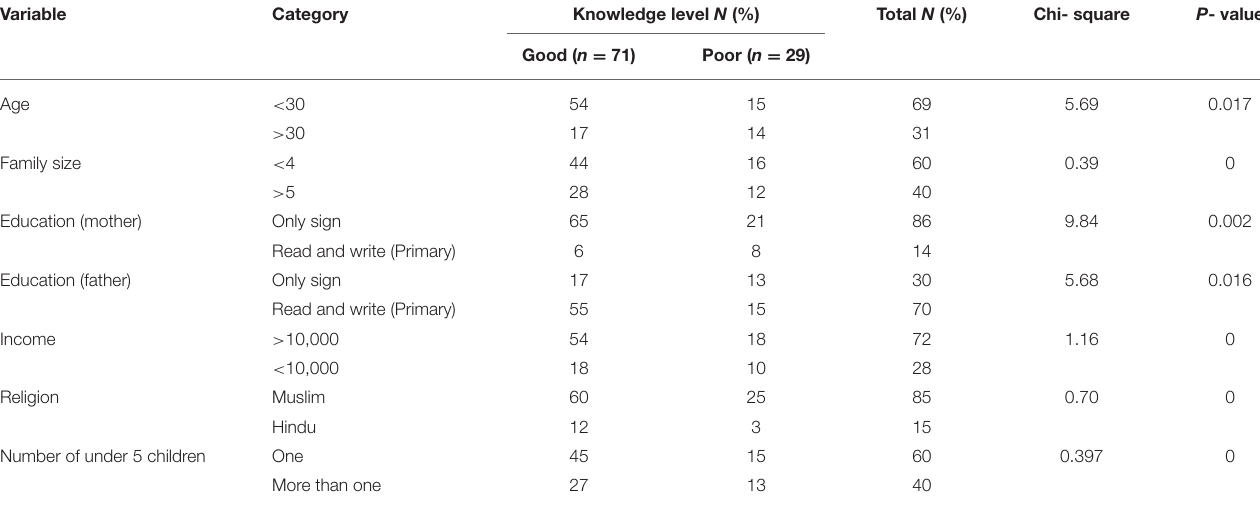
TABLE 1 | Socio-demographic characteristics of the respondents.